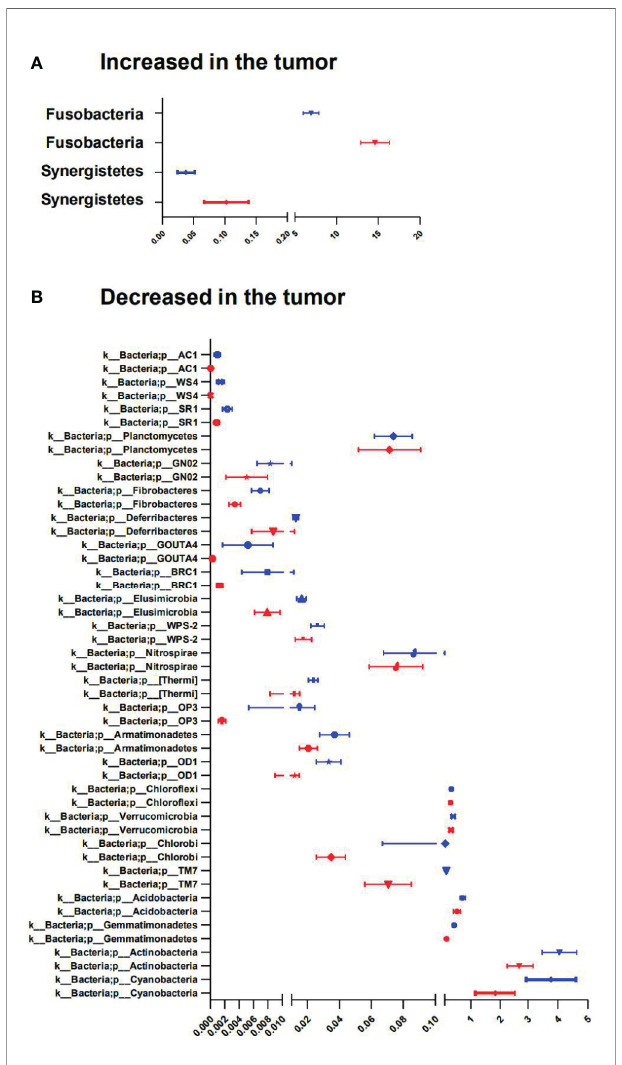
FIGURE 5 | Phyla involved in tumor-associated signature with CRC. (A, B) Relative abundance of signi fi cantly different phyla between tumor and adjacent normal tissues. The two-sided Wilcoxon signed rank test was used to evaluate the importance of comparisons. Tumor (red bars), Adjacent normal (blue